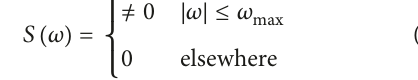
Figure 2: Oversampled signal 𝑦(𝑡) . Band limitation is achieved by definition of the signal. Mention that the first sample and the 𝑖 at 𝑡 = 1 would be the same, because of the periodicity of the